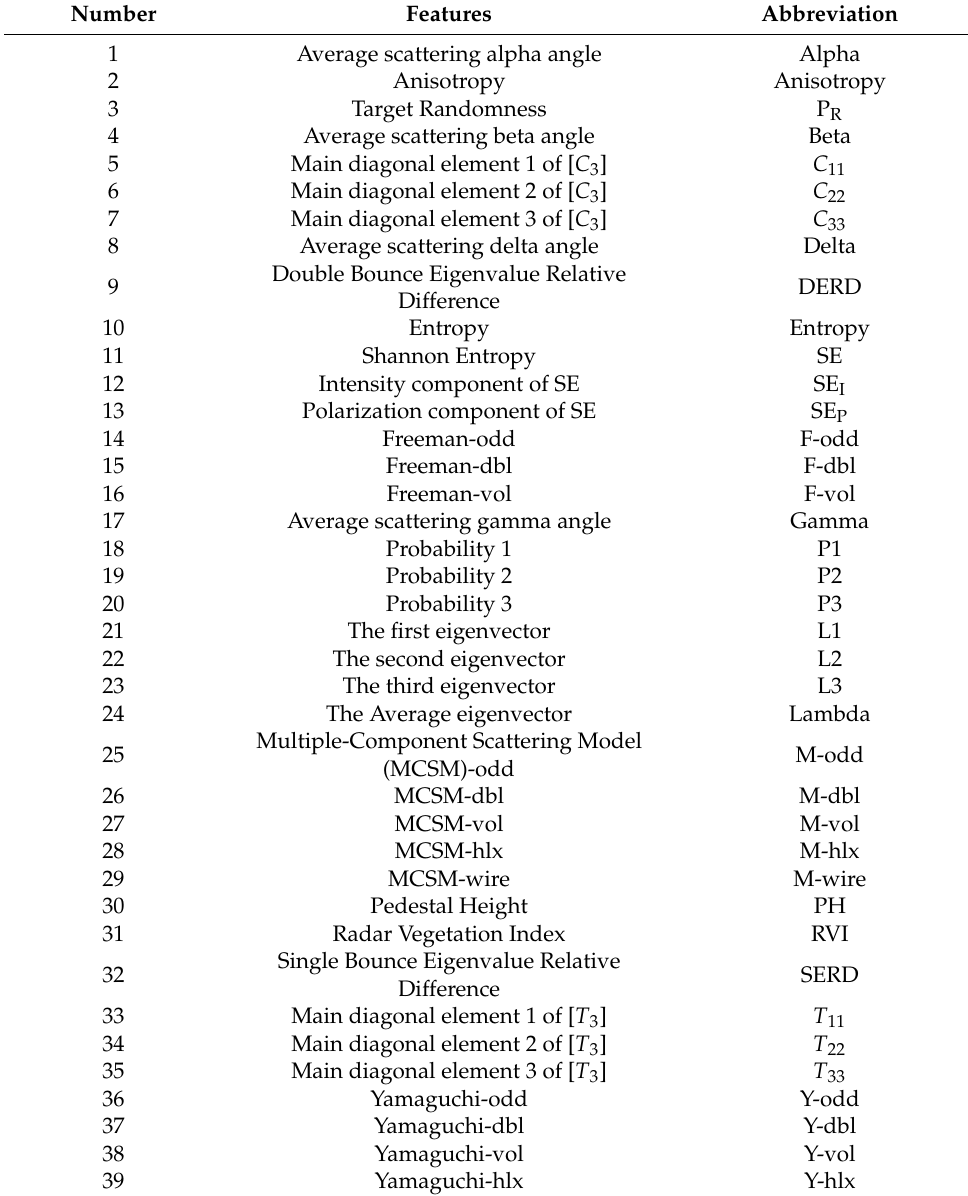
Table 3. Overview of the 39 features extracted from the RADARSAT-2 PolSAR